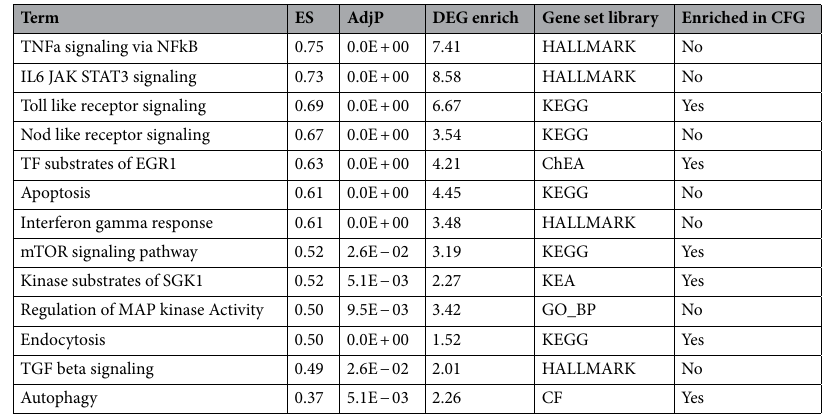
Table 1. Selected terms from enrichment analysis of the CF-Meta signature. ES enrichment score, AdjP adjusted p -value, DEG Enrich fold enrichment, denoting the ratio of the number of CF-Meta DEGs observed vs. expected within the gene set, Enriched in CFG whether the term was also significant in the CFG enrichment